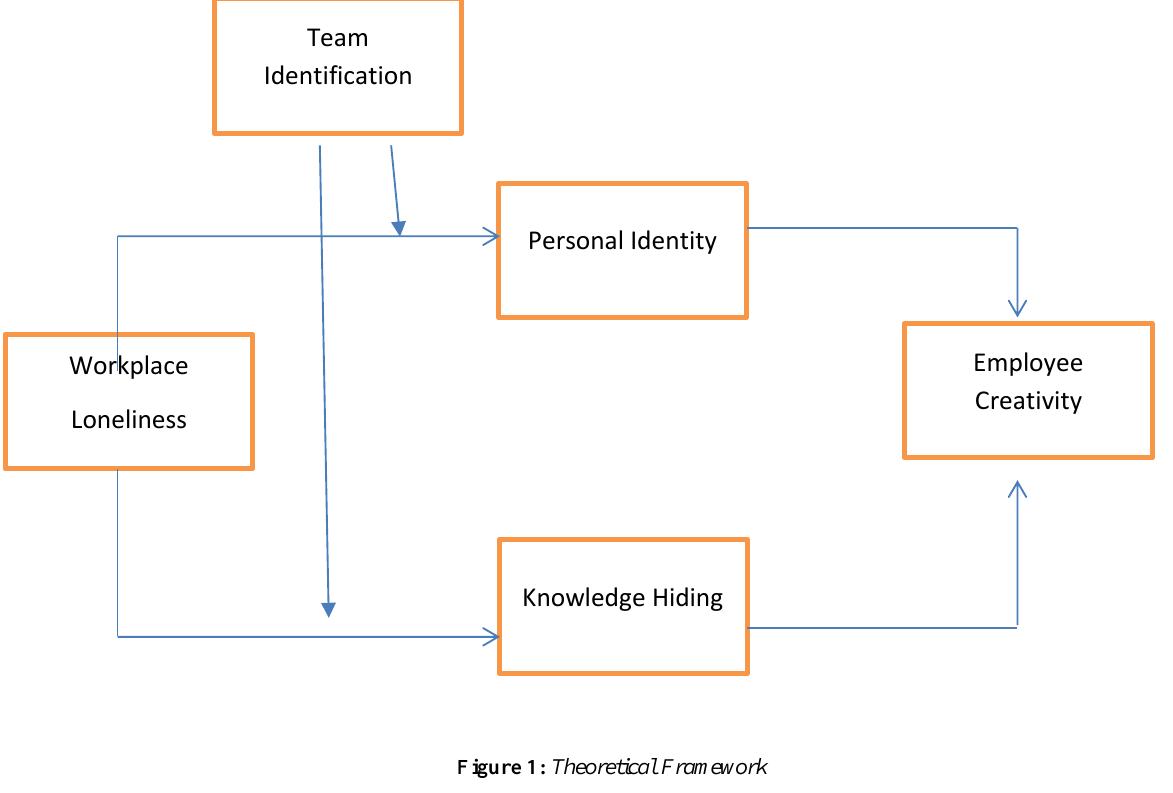
Figure 1: Theoretical